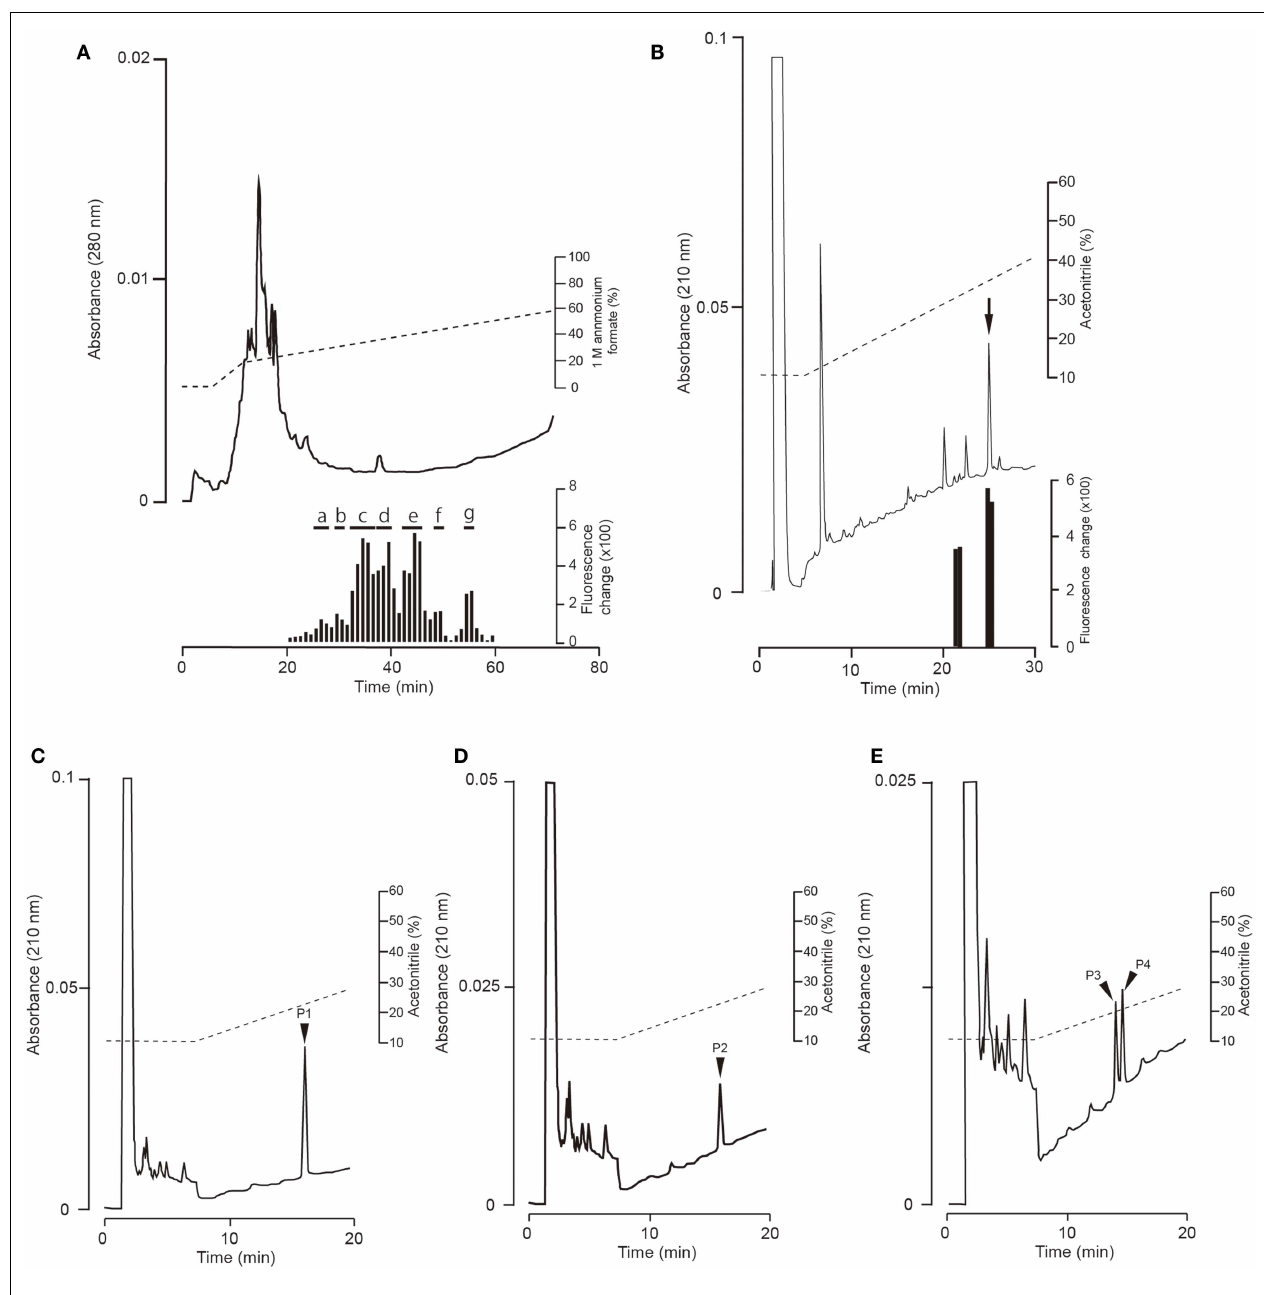
major peak. (C) Reverse-phase HPLC of group “e” on a diphenyl column.The peak labeled P1 corresponds to the peak indicated by the arrow in (B) ; this peak corresponds to the peptide obtained in the highest yield from the stomach of fish fed normal feed. (D) The peptide (P2) obtained in the second highest yield (isolated from group “g”). (E) The peptides (P3 and P4) obtained in the third and fourth highest yields (isolated from group “c”).